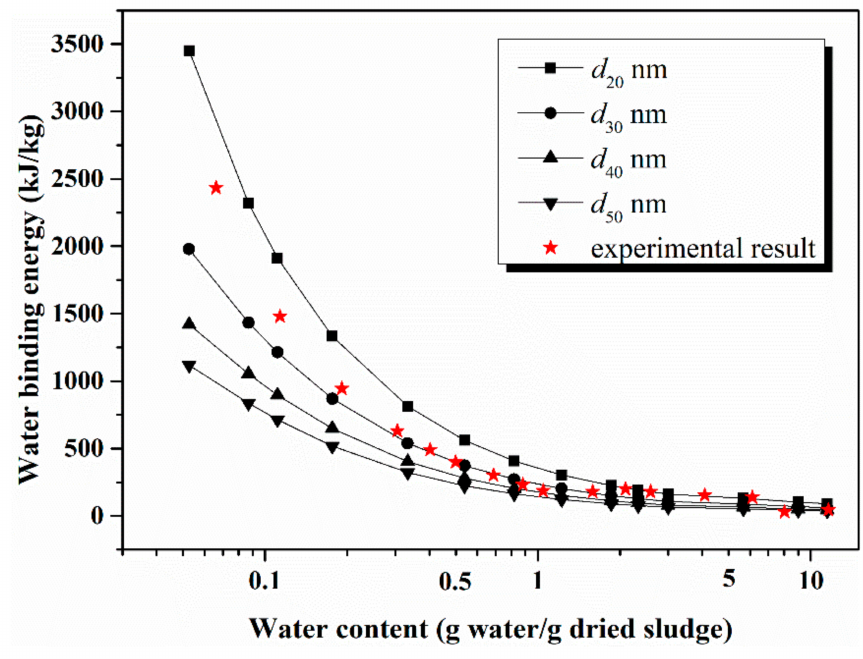
Figure 4. Experimental and model results for the LS